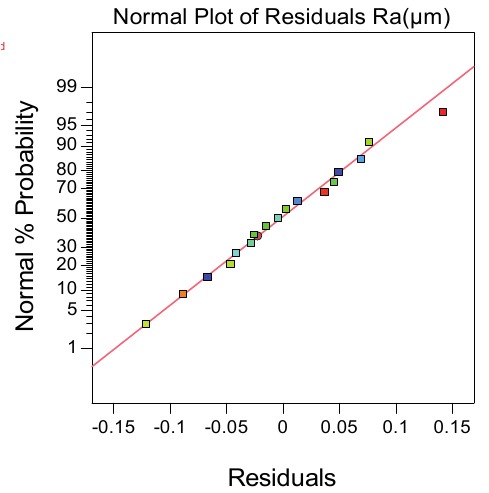
Fig. 12. Normal probability plots for surface roughness Fig. 13. Normal probability plots for cutting force .